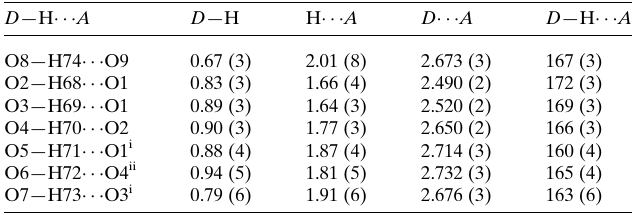
Table 1 Hydrogen-bond geometry (A˚ , (cid:4) ).